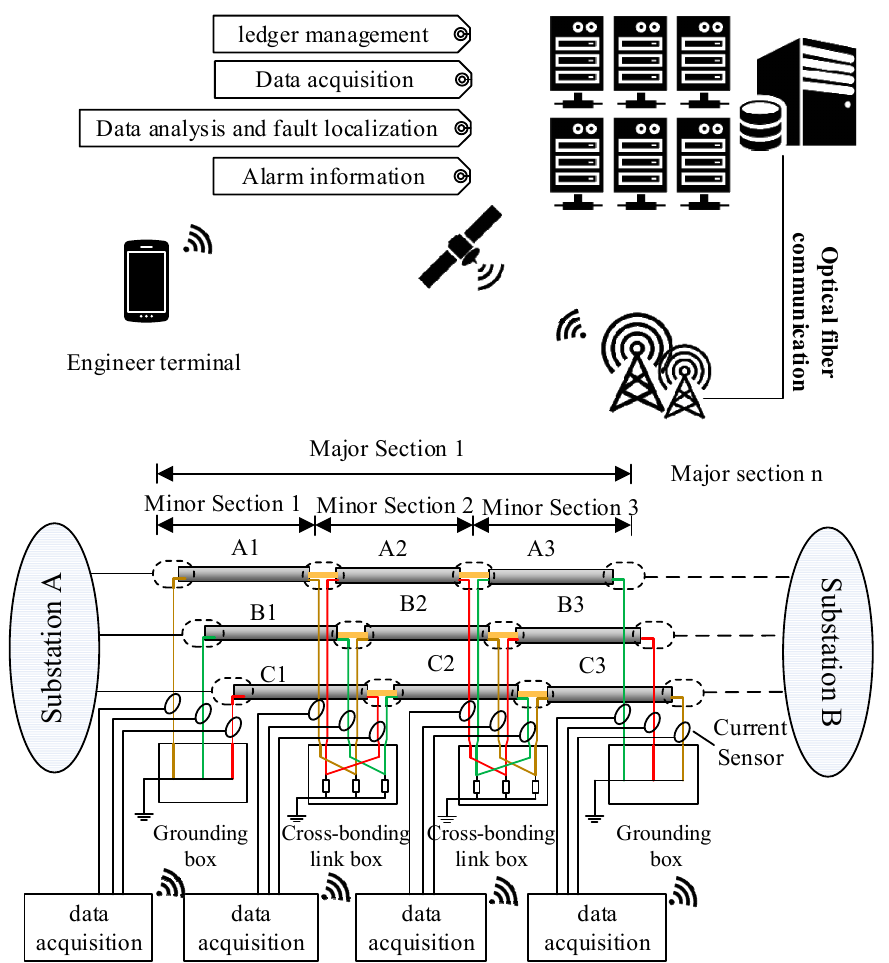
Figure 3. The online sheath currents monitoring system.